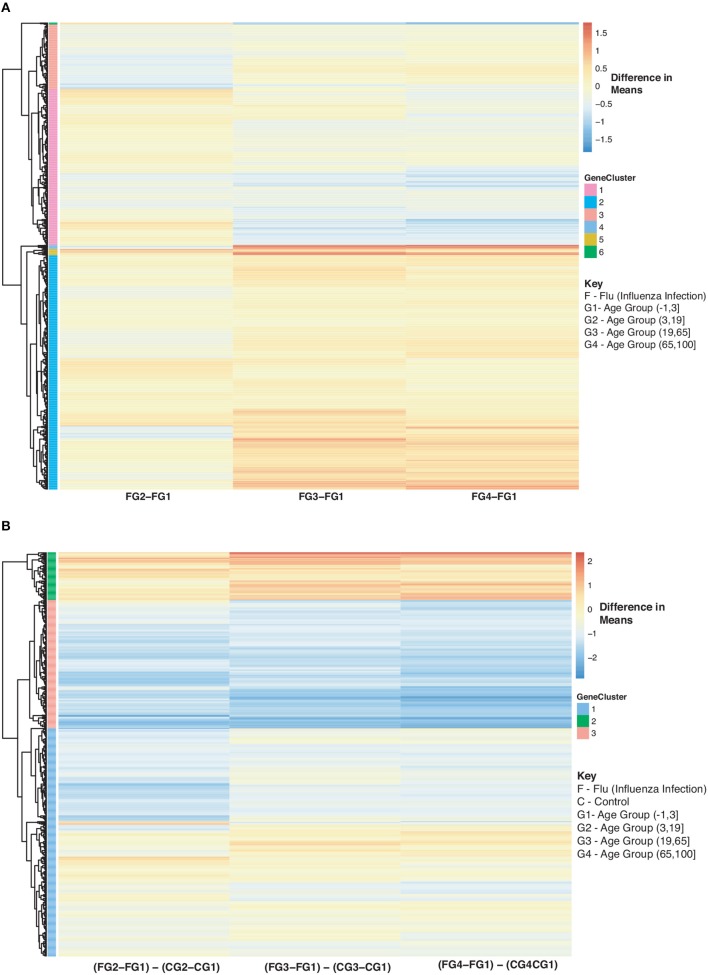
Heatmap of Statistically Significant (Bonferroni-adjusted p < 0.05) Genes with an Interaction Between Disease State and Age for Influenza Infected Subjects. (A) Difference in means calculated by comparing influenza infected subjects in age groups 2–4 to influenza infected subjects in age group 1 (baseline). (B) Comparison of influenza infected subjects to control subjects in the different age groups by calculating the difference between the baseline-adjusted means for influenza infected subjects (A) and control subjects (Figure 8).